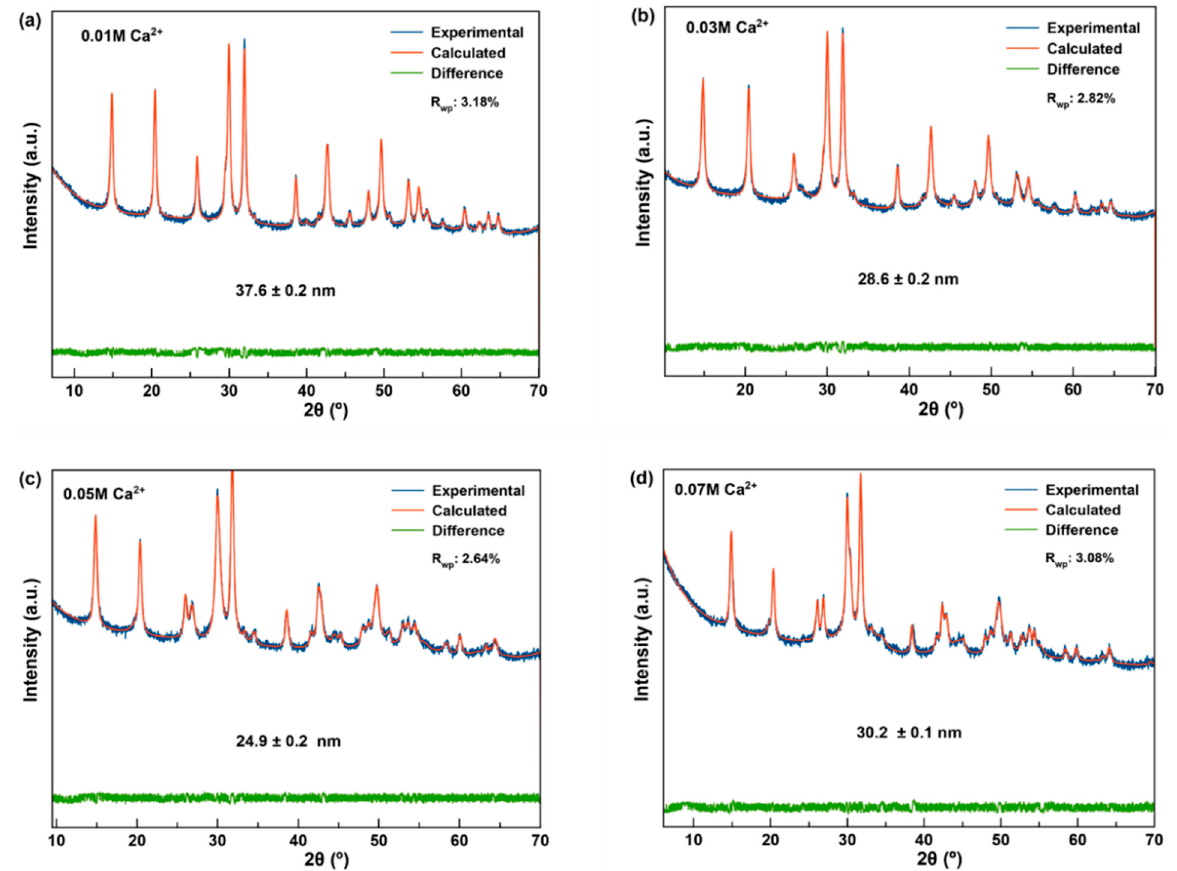
Figure 2. Crystalline domain sizes of Ca 2+ :TbPO 4 · nH 2 O nanoparticles prepared with, ( a ) x = 0.01 M; ( b ) x = 0.03 M; ( c ) x = 0.05 M and ( d ) x = 0.07 M Ca 2+ for 96 h, calculated by analysis of the full XRD pattern using TOPAS 6.0. The two XRD vaterite reflections are excluded. R wp , weighted profile R-factor as described in Young [37].